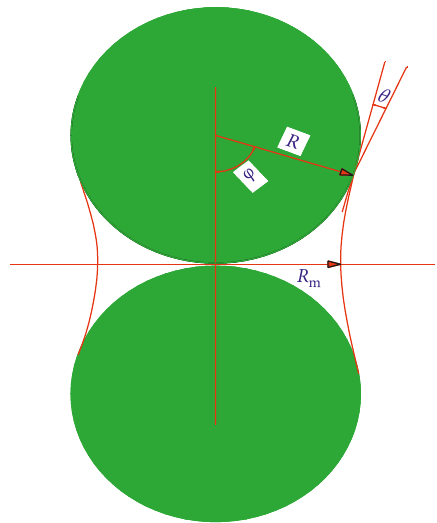
Figure 8: Model of grain-water molecule interactions.